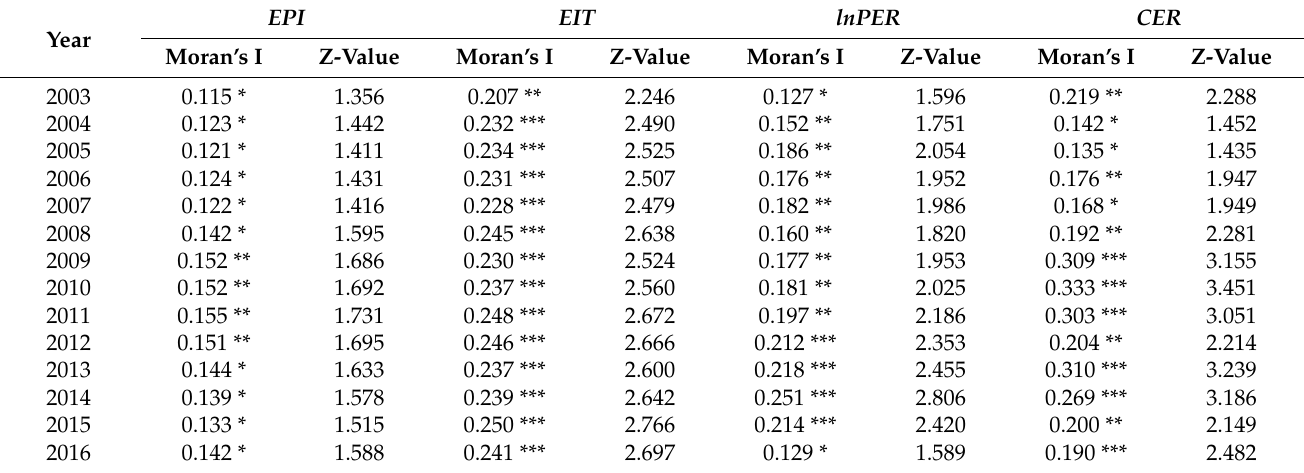
Table 2. Spatial correlation tests for core